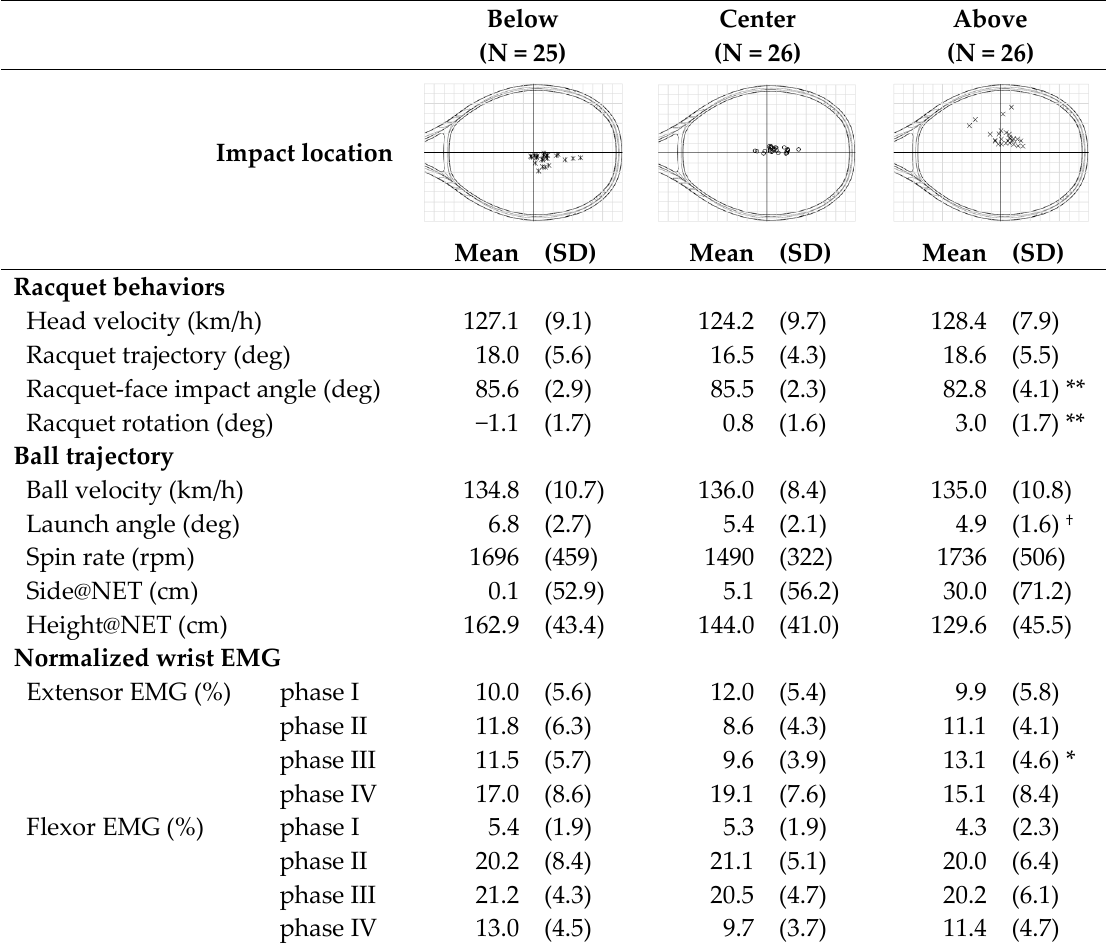
Table 1. Summarized